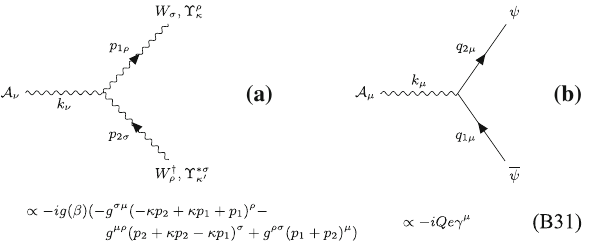
Fig. 34 a Spin-1 bosonic monopoles interacting with gauge field at the three-point vertex, where g (β) is the magnetic coupling. b The quarks couple to the photon as expected form Dirac QED for spinors with fractional charges, Qe , where Q is the charge fraction relevant to , 2 the quarks involved, Q = 1 . The corresponding Feynman rules are 3 3 given in